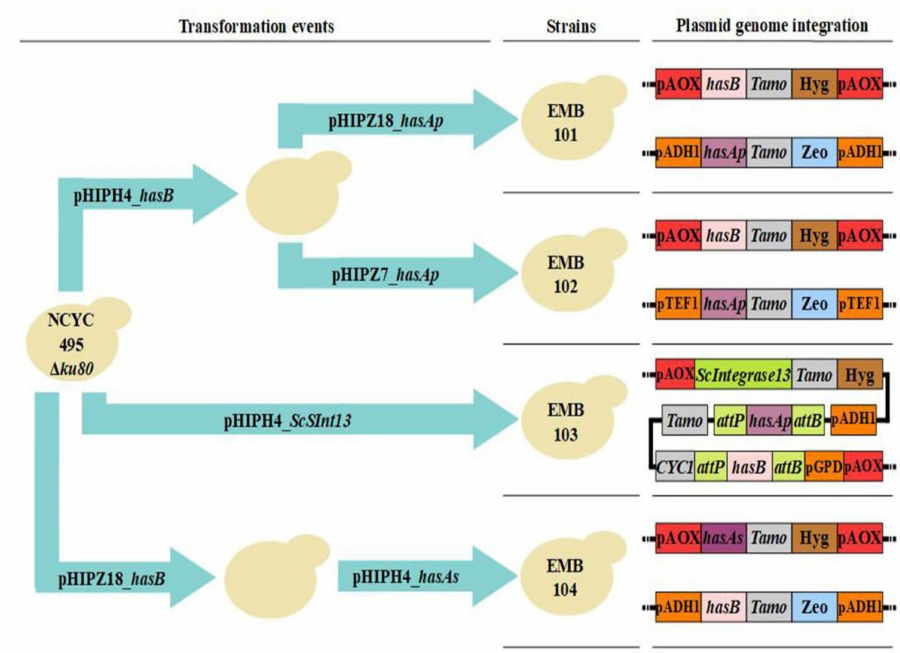
Figure 2. Strains constructed in this study to evaluate HA production in O. polymorpha . Light blue arrows represent transformation events with the plasmids specified. Integration of plasmids by single crossover is depicted. Hyg: hygromycin resistance cassette. Zeo: zeocin resistance